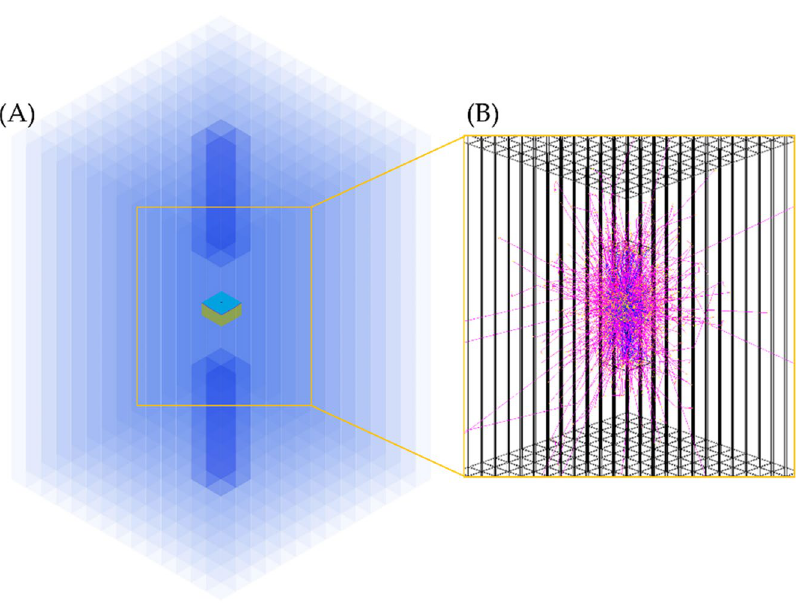
Figure 4. ( A ) The simulation geometry of the KAPAE detector excluding SiPMs. BGO scintillator bars are shown in blue. The yellow box with a cyan top at the center of the KAPAE detector represents the trigger system including the radioactive source. ( B ) A simulated 2-γ decay system. Red lines represent tracks of charged particles produced from interactions of γ-rays with the BGO